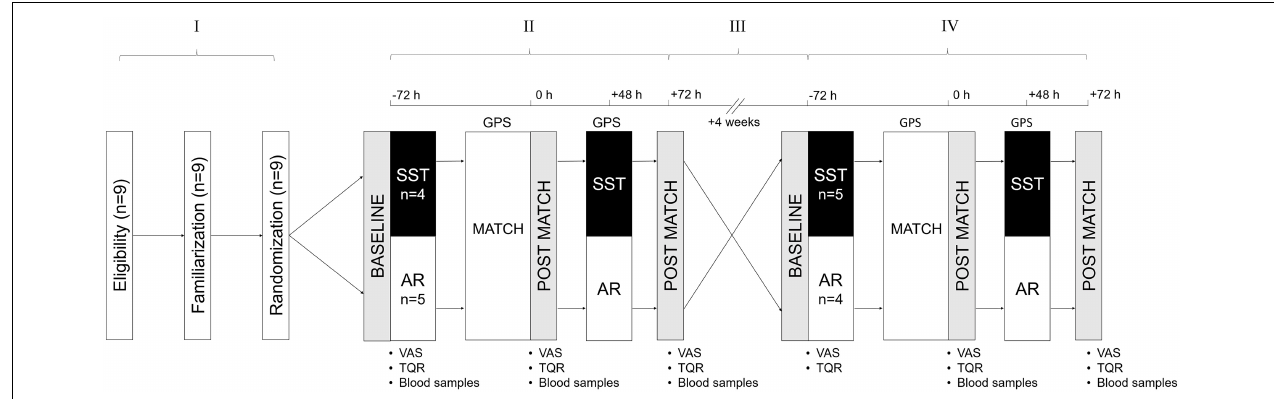
FIGURE 1 | A schematic representation of the experimental schedule. The group-specific training interventions were completed 48 h after the match, while VAS scores and blood samples were collected before ( − 72 h), immediately (0 h), and after (72 h) the match. GPS, global positioning system; SST, sport-specific training session; AR, active recovery session; VAS, visual analog scale; TQR, total quality of